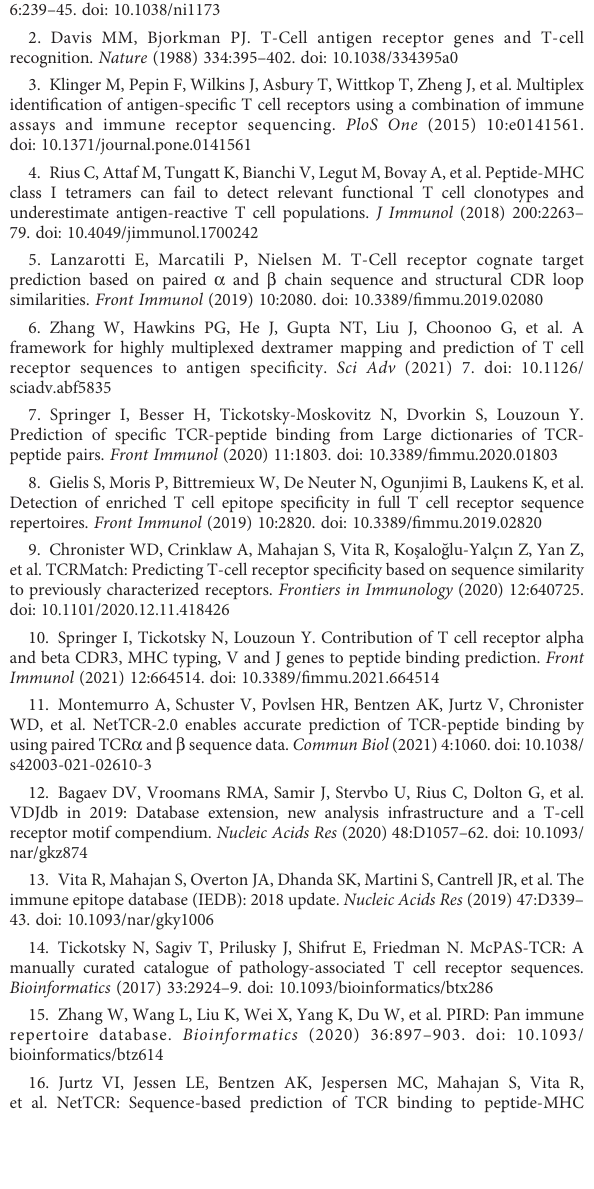
SUPPLEMENTARY FIGURE 5 NetTCR versus TCRbase. Performance comparison in terms of AUC01 and PPV. The values are reported for each peptide, and differentiated according to the two prediction tasks, positives vs 10x negatives and positives vs swappednegatives. “ average ” iscalculatedas an averageofthe AUC01 (and PPV) of the peptide-speci fi c scores; “ w_average ” is a weighted average (weighted by the number of positive TCRs) of the peptide-speci fi c